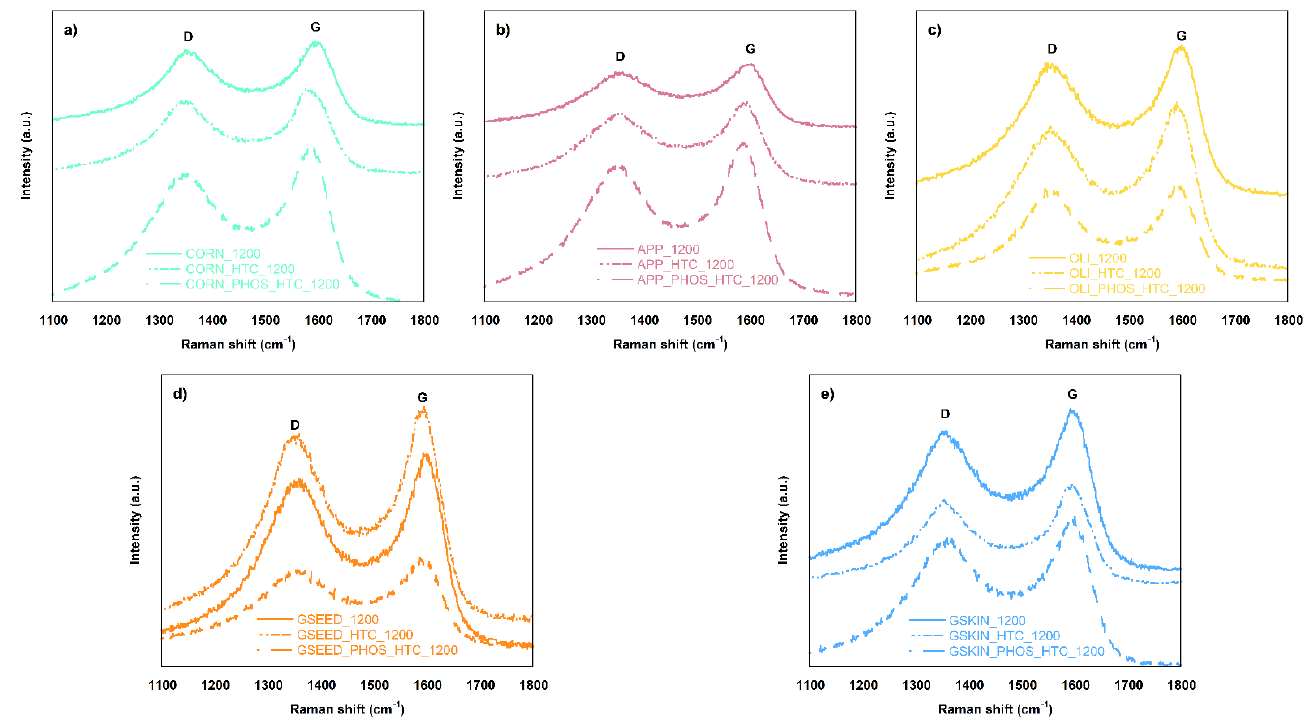
Figure 3. Raman spectra of corn cob ( a ), apple pomace ( b ), olive mil solid waste ( c ), grape defatted seed ( d ) and dried grape skin ( e ) samples. Table 3. Physical parameters of the samples calculated from XRD and Raman